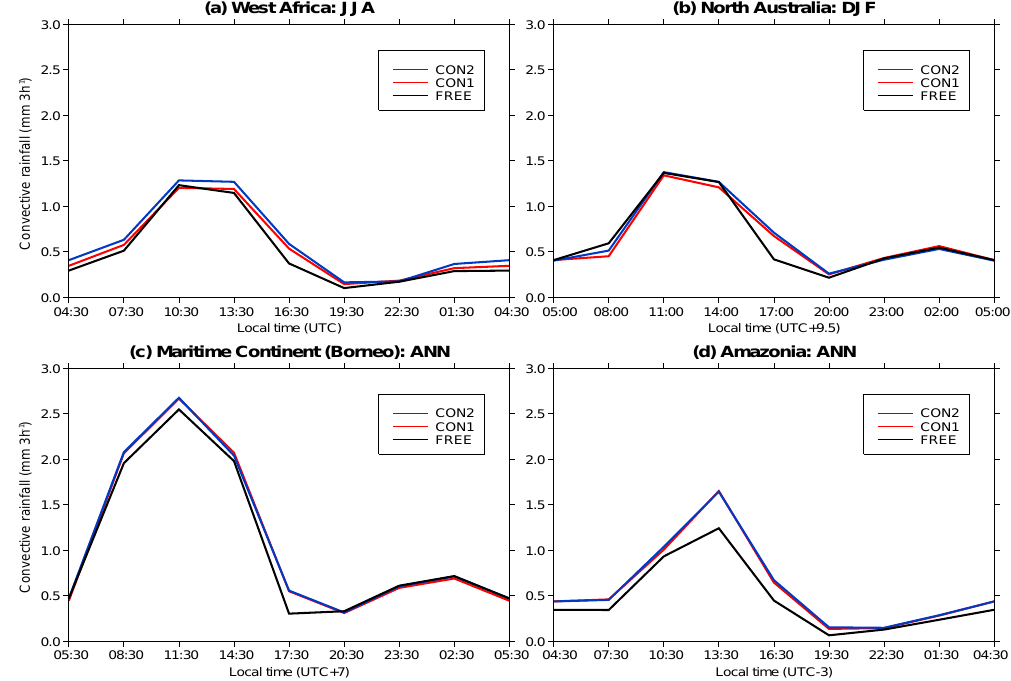
Figure 5. Diurnal cycle of convective precipitation in the tropics (mm3h − 1 ) at (a) 0 ◦ E and 15 ◦ N (West Africa) in JJA, (b) 135 ◦ E and 15 ◦ S (northern Australia) in DJF, (c) 112.5 ◦ E and 0 ◦ N (Borneo, equatorial island) annual mean, and (d) 300 ◦ E and 0 ◦ N (Amazon, equatorial continental) annual